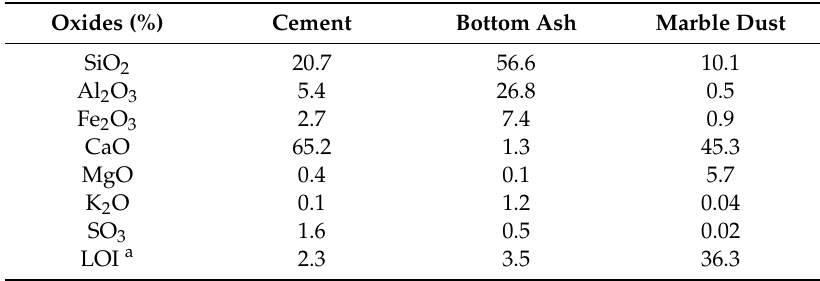
Table 1. Chemical composition of cement, bottom ash and marble